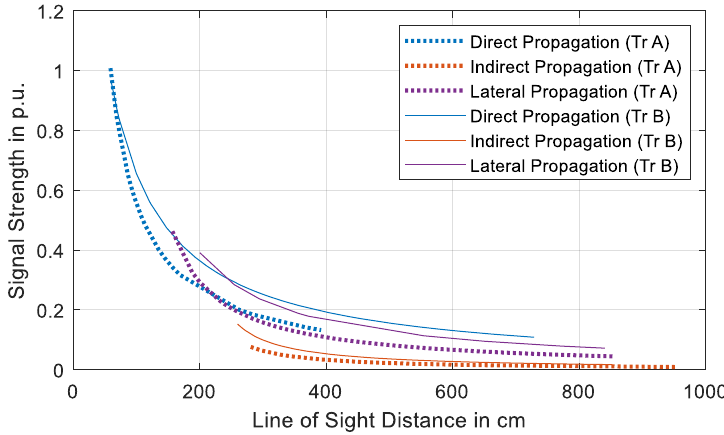
Figure 6. Comparison of signal propagation paths in transformers A and B.